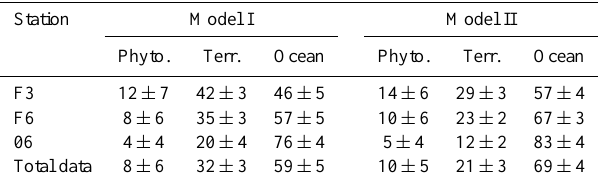
Table 5. Relative concentration of RDOC (%) ± error ∗ in Tokyo Bay derived from phytoplankton, terrestrial, and open-oceanic waters, estimated from two multiple linear regressions. ∗ See Sect.